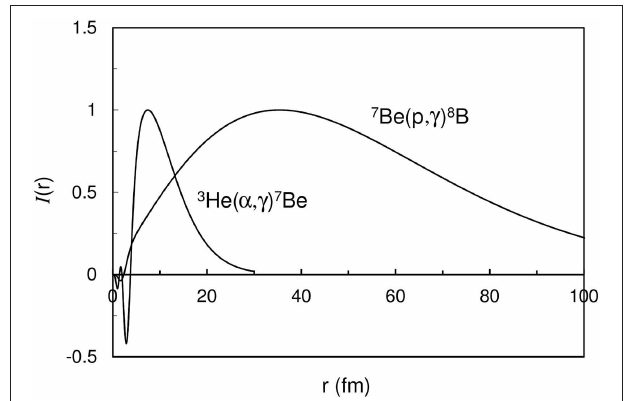
FIGURE 5 | Integrand (58) at 0.02 MeV for 7 Be(p, γ ) 8 B, and at 0.1 MeV for 3 He( α , γ ) 7 Be ( λ = 1). The normalization is